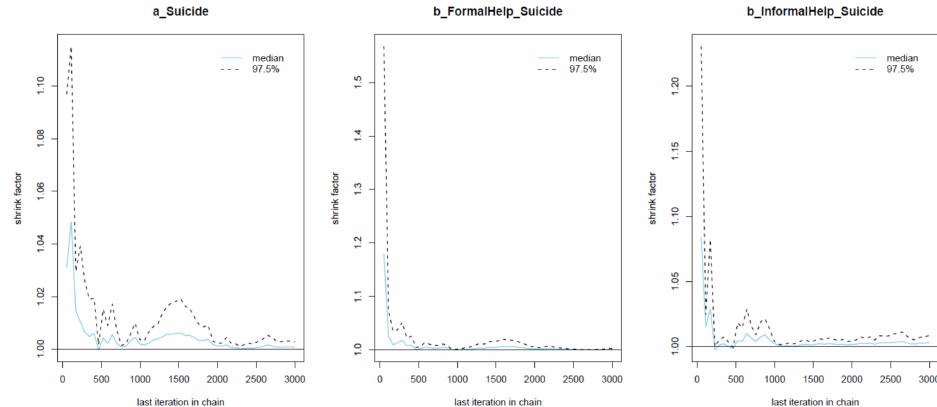
Figure A7. Gelman plots for Model 4 (cid:48) s posterior coefficients.